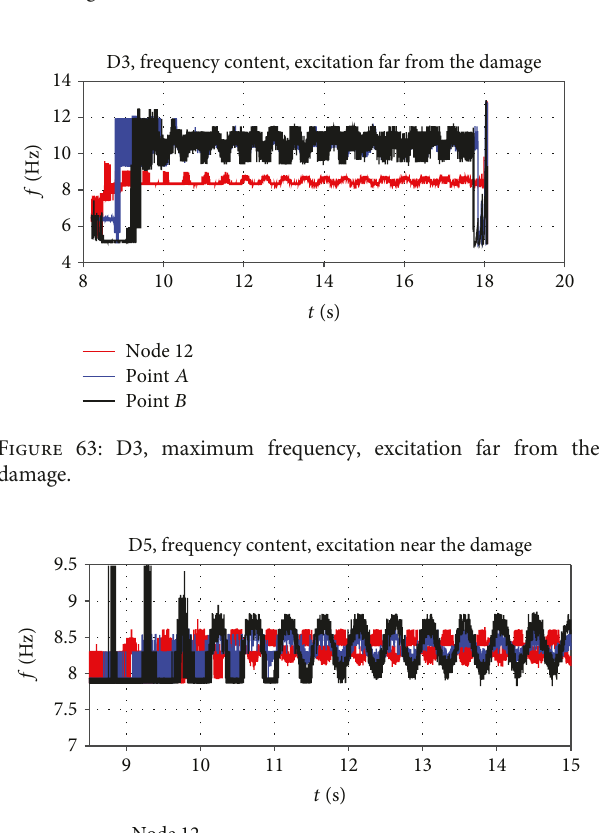
Figure 62: D3, maximum frequency, point B , excitation near the damage.